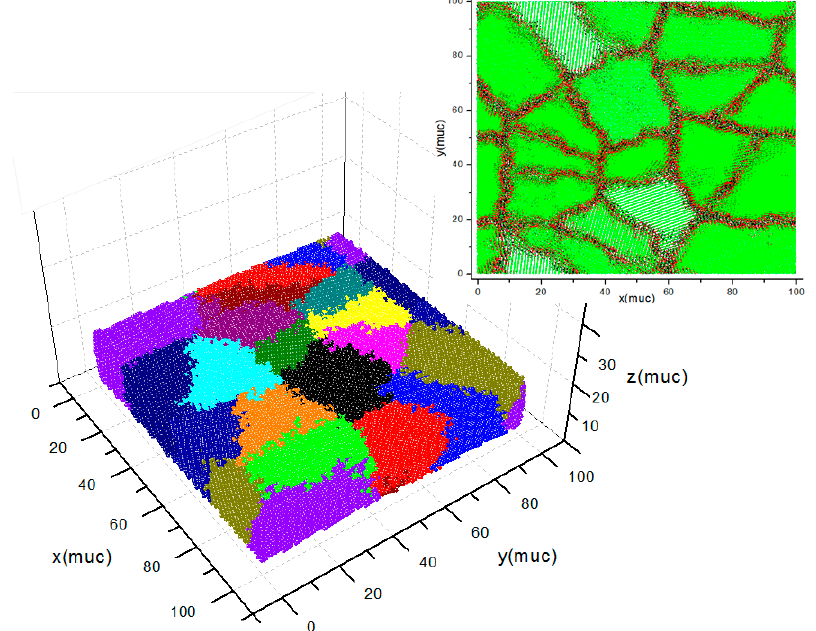
Figure 1. Polycrystalline sample with L = 100 muc and d = 100 muc, N g = 16. The periodic boundary conditions along the xy plane can be identified by the colour distribution. The figure inset corresponds to the surface view, showing the grain boundaries.